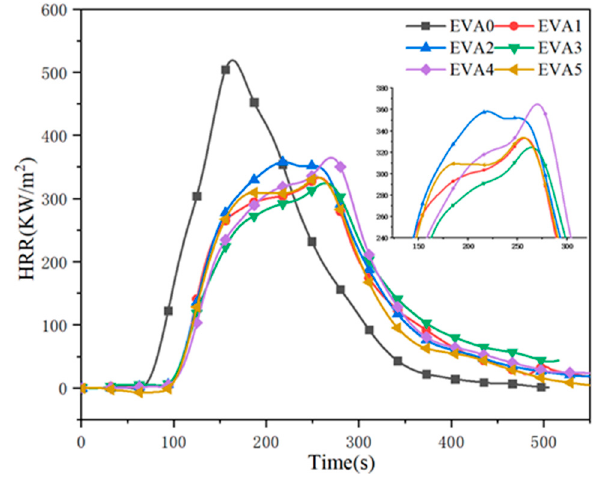
8 of 14 Figure 7. Digital photos of neat EVA and EVA/MH composites after LOI test. 3.5. Combustion Behavior The cone calorimeter test (CCT) is a widely used method for determining seniority and comparing the combustibility of polymeric materials [2,23,24]. Herein, the heat re- lease rate (HRR) curves of neat EVA and EVA/MH composites are depicted in Figure 8, and the comprehensive data are summarized in Table 5. It can be seen that the peak of the HRR curve of EVA0 was higher than that of the other specimens, and the time to ignition (TTI) of EVA0 also happened earlier, which denotes a faster flame spread and major fire hazard [25,26]. Specifically, the neat EVA burnt out within 552 s, and at 100 s, the peak